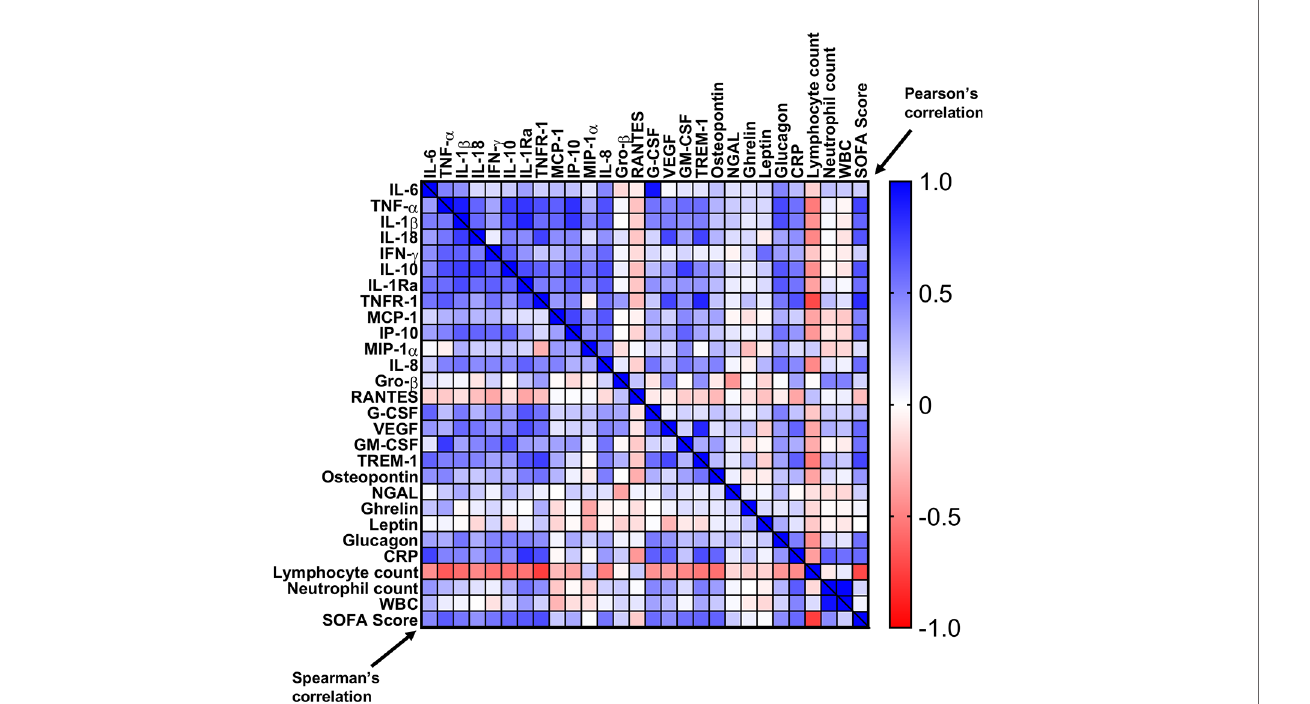
FIGURE 9 | Correlation matrix of cytokines, chemokines, and immunomodulators with SOFA score, CRP, and blood counts. A correlation heat-map of the tested cytokines/chemokines, HGFs, and immunomodulators with CRP, SOFA score, and blood counts. Pearson ’ s r values are on the top right and the Spearman ’ s r values are on the bottom